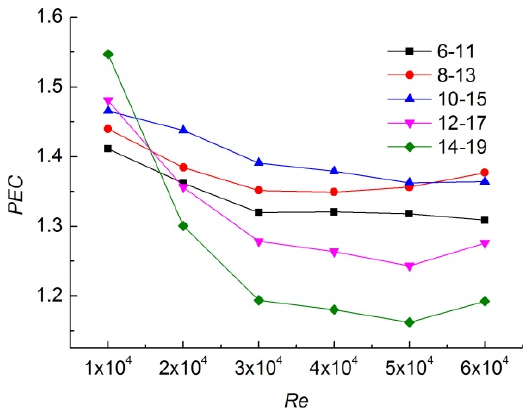
Figure 10. The variation of PEC of pipe pass with Re.